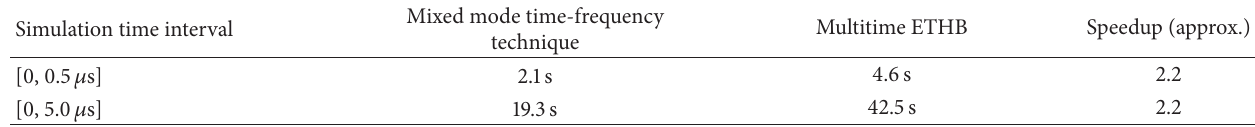
Table 1: Computation times—resistive FET mixer.